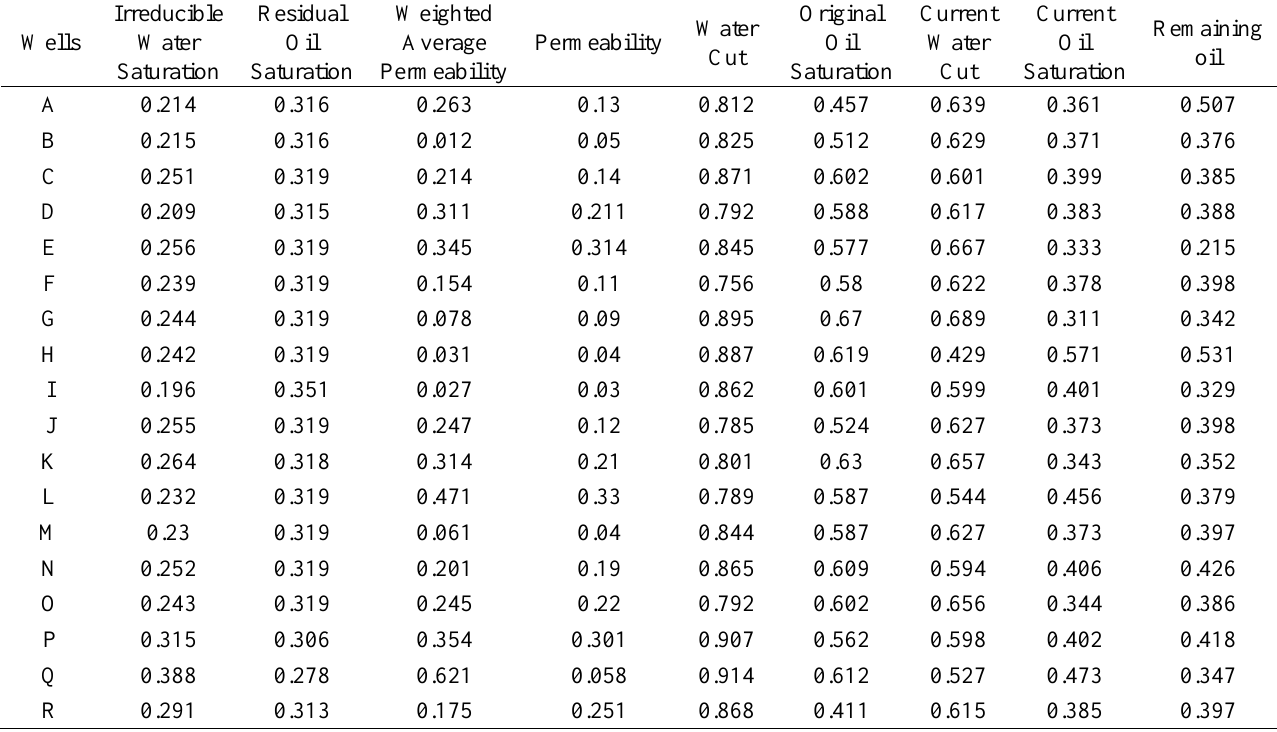
Table 2—Comparison of calculated ROS value and numerical simulation results (part of wells).